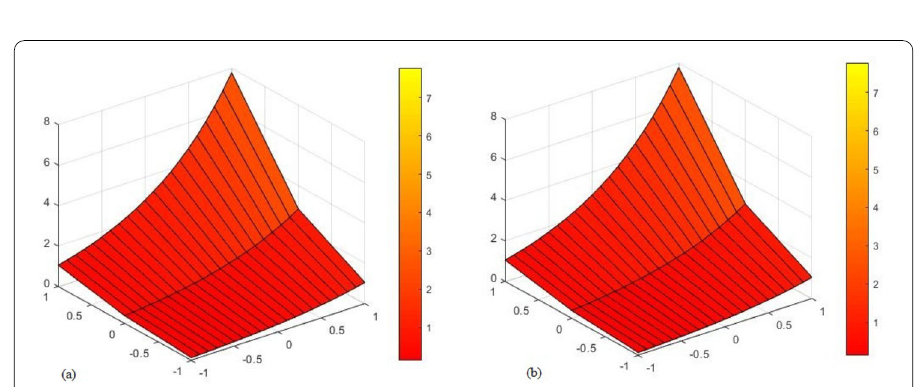
Figure 10 The graph of exact ( a ) and approximate ( b ) solution of (cid:13) ( χ , ϕ , η ) at ϒ = 1 of Example 2